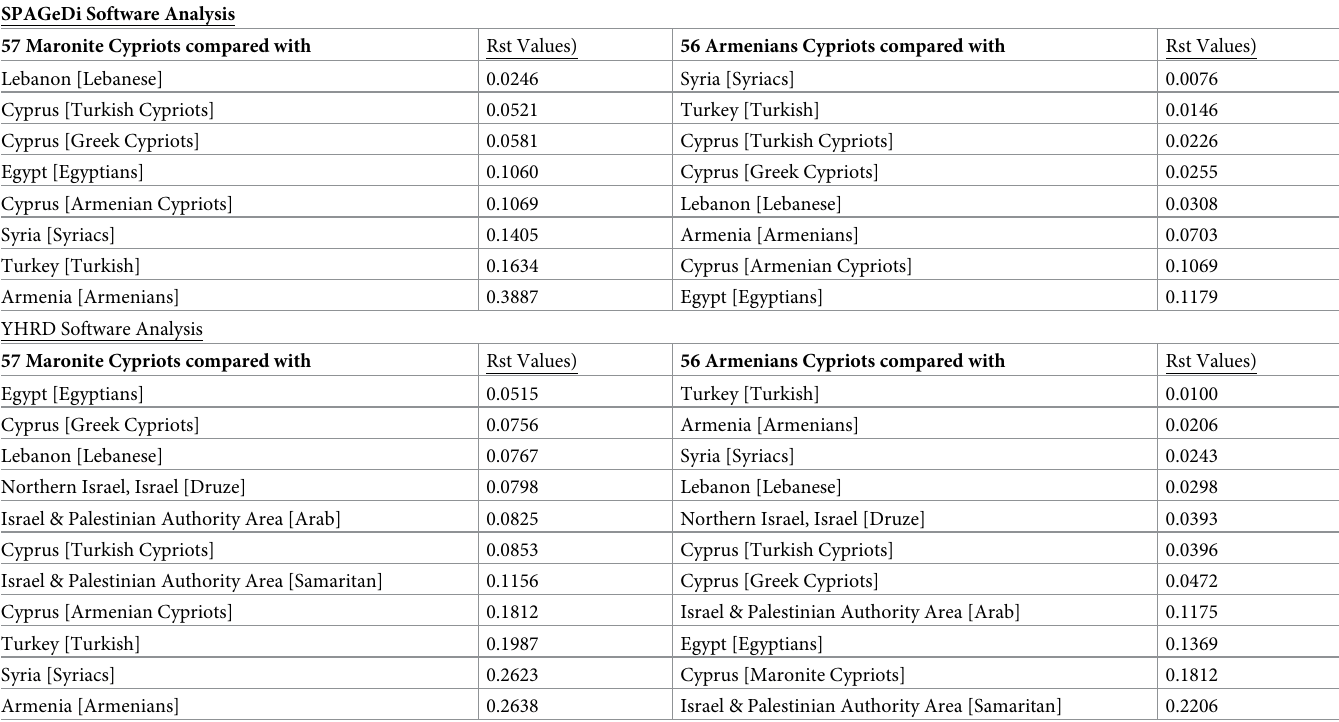
Table 3. Pairwise genetic distances (Rst values) between Maronite and Armenian Cypriots and countries from which they originated before coming to Cyprus. SPAGeDi Software